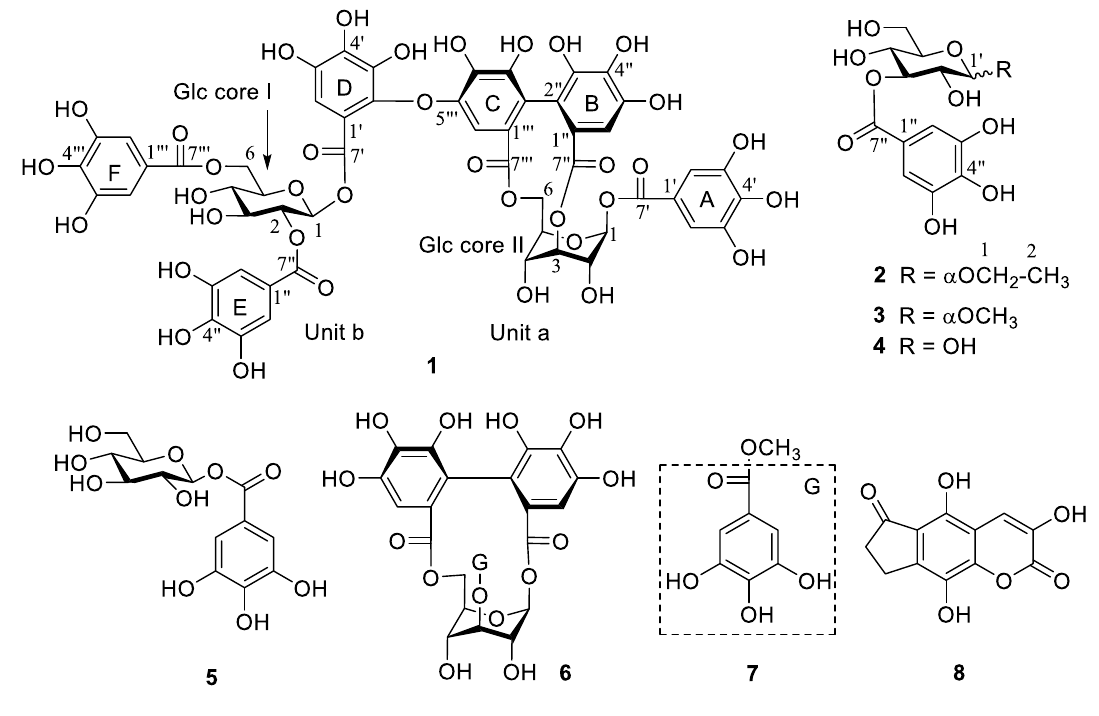
Fig. 1 Chemical structures of 1 – 8 from E.